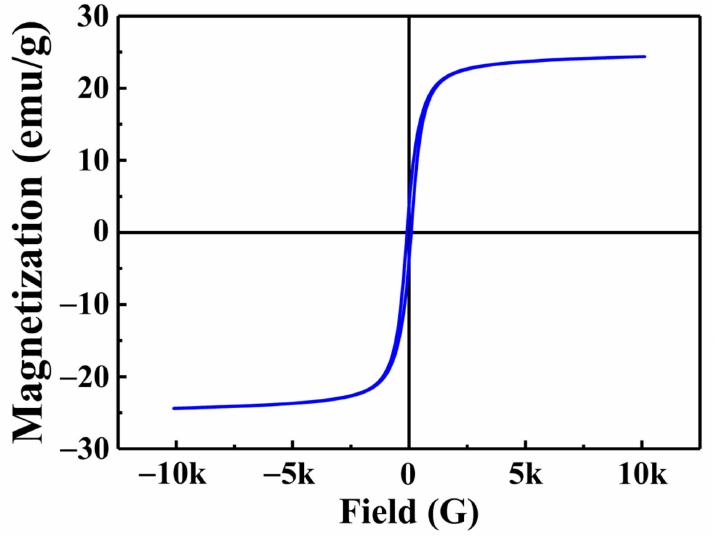
Figure 3. Magnetization curves of